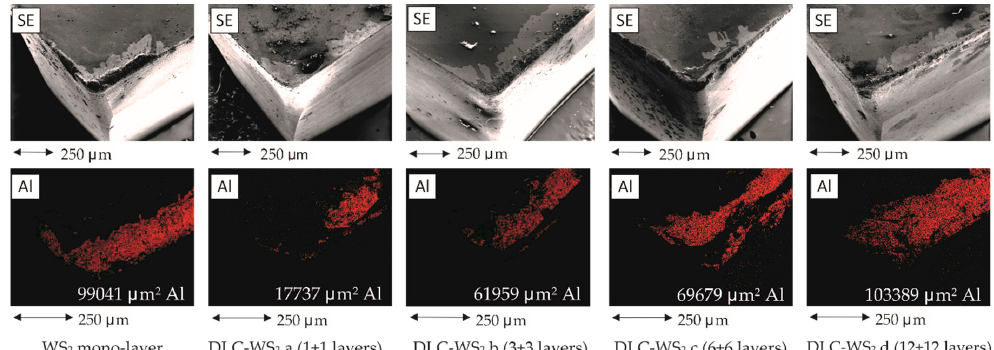
Figure 11. Aluminium element mapping images of the flank face of mill insert with multilayered Figure 11 DLC-WS 2 coating after face milling of AlSi alloy. Element mapping obtained with EDX mode of